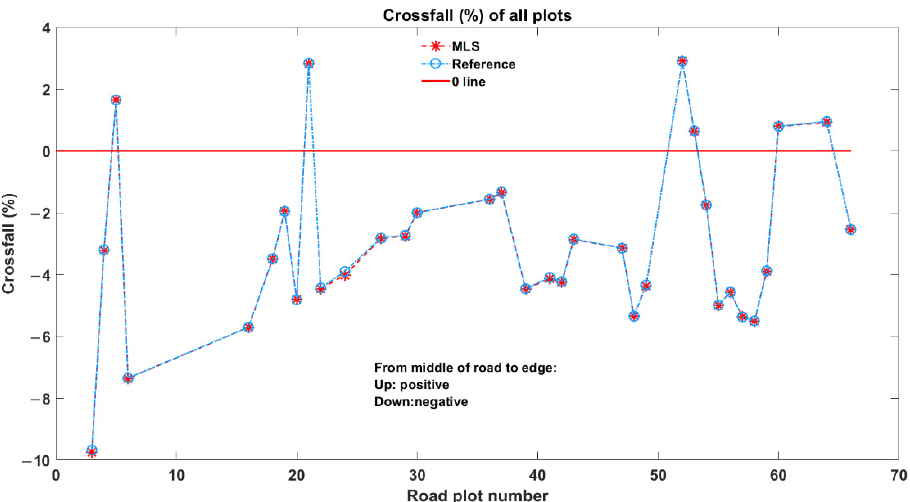
Figure 20. Crossfall estimation results from MLS (red dashed starred line) and reference (blue dashed circle line).